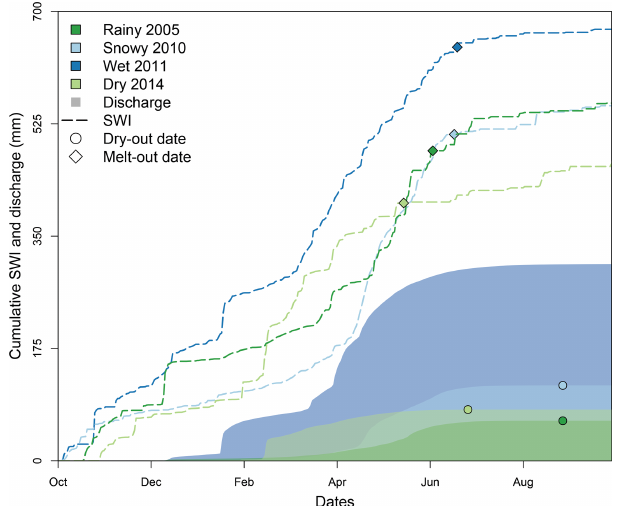
Figure 5. Cumulative surface water inputs (SWI, dashed lines, mm) and discharge (colored polygons, mm) for each of the water years (dark green – rainy 2005, light blue – snowy 2010, dark blue – wet 2011, and light green – dry 2014). Circles indicate the day on which the stream ceased to flow at the catchment outlet (dry-out date; please note that the stream did not cease to flow in 2011), and diamonds indicate the day on which all snow had melted from the catchment (melt-out